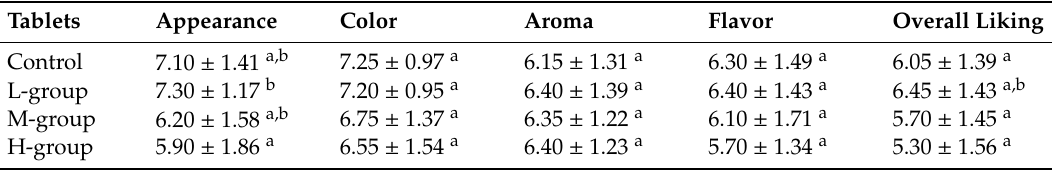
Table 7. Organoleptic assessment of the lactobacilli e ff ervescent tablets supplemented with di ff